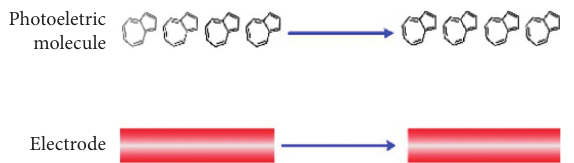
Figure 2: Changing situation of target organisms in the polluted ecological environment.